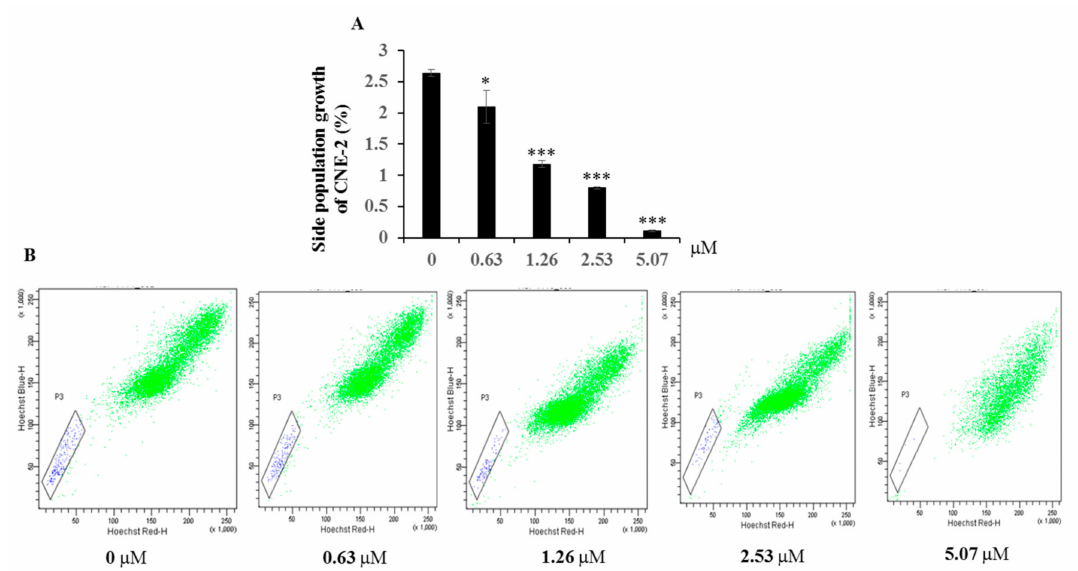
Figure 4. Compound 1 effect of side population growth CNE-2. ( A ) Compound 1 inhibited side population growth in a concentration-dependent manner as determined by FCM analysis. ( B ) The inhibition was visualized by adding Annexin-FITC and PI at different concentrations. * p < 0.05, *** p < 0.001 compared with the control group. Data are expressed as the mean ± SD. n =